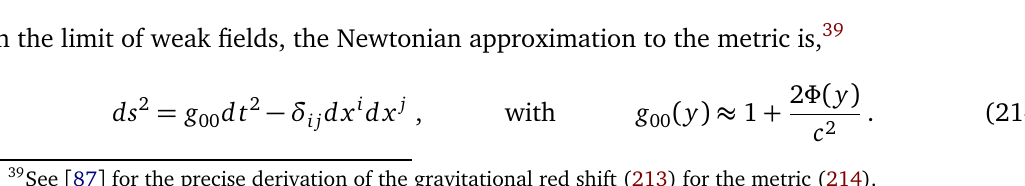
Figure 16: Quantum Hall bar placed in a gravitational field along the y direction, with upper edge kept at temperature T edge modes are indicated by blue arrows. figure from [ 86 ]